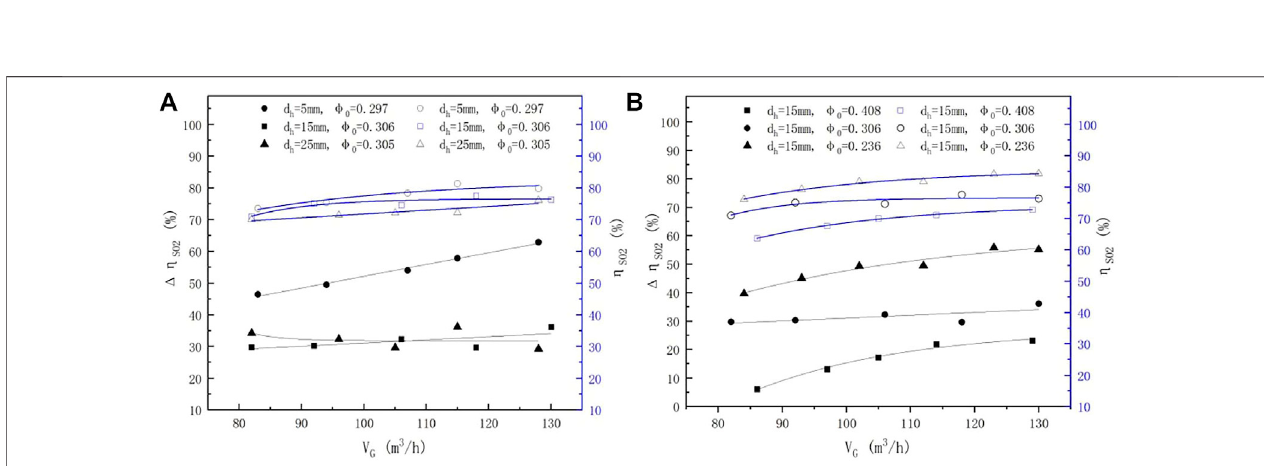
FIGURE6| Δη SO2 and η SO2 underdifferentgas fl owrateswiththesameL/G(L/G=16,C SO2 =750±100 mg/m 3 ,andpH=6), (A) porediameter,and (B) porosity.